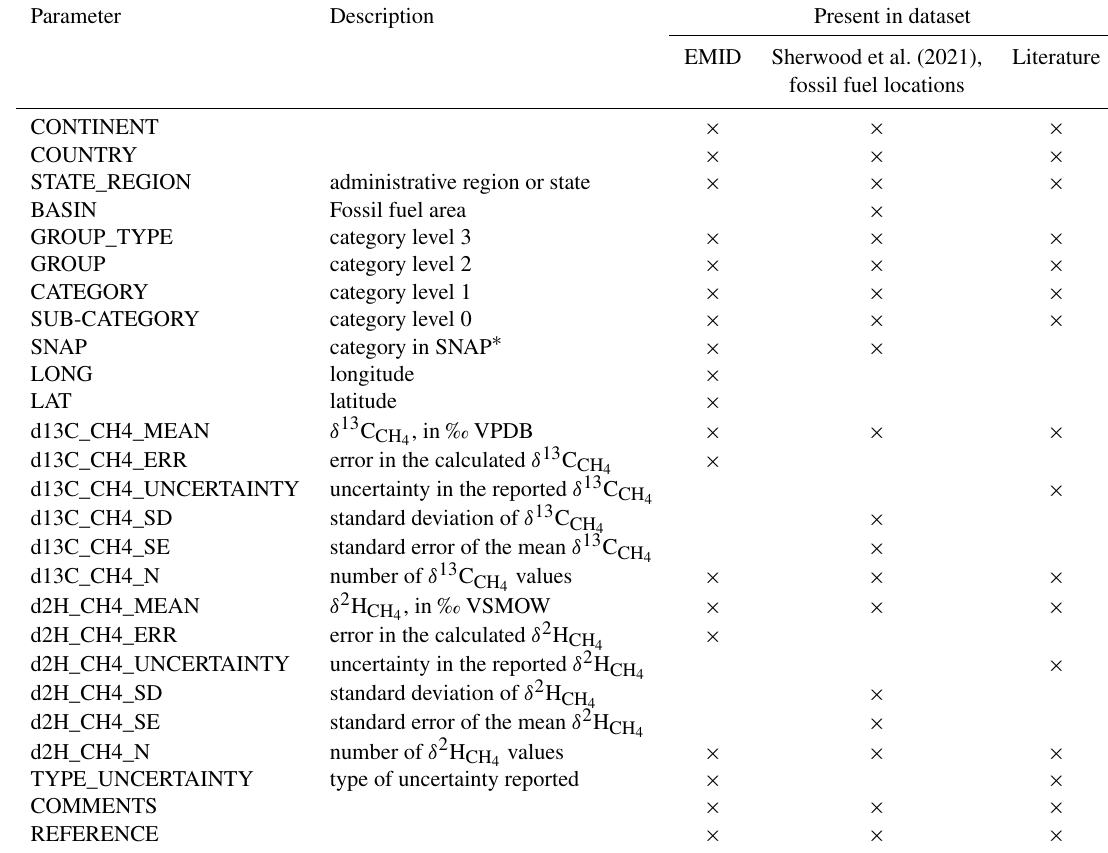
Table 1. Variables reported in the CH 4 isotopic signature database published with this article, which combines three datasets of different origins.